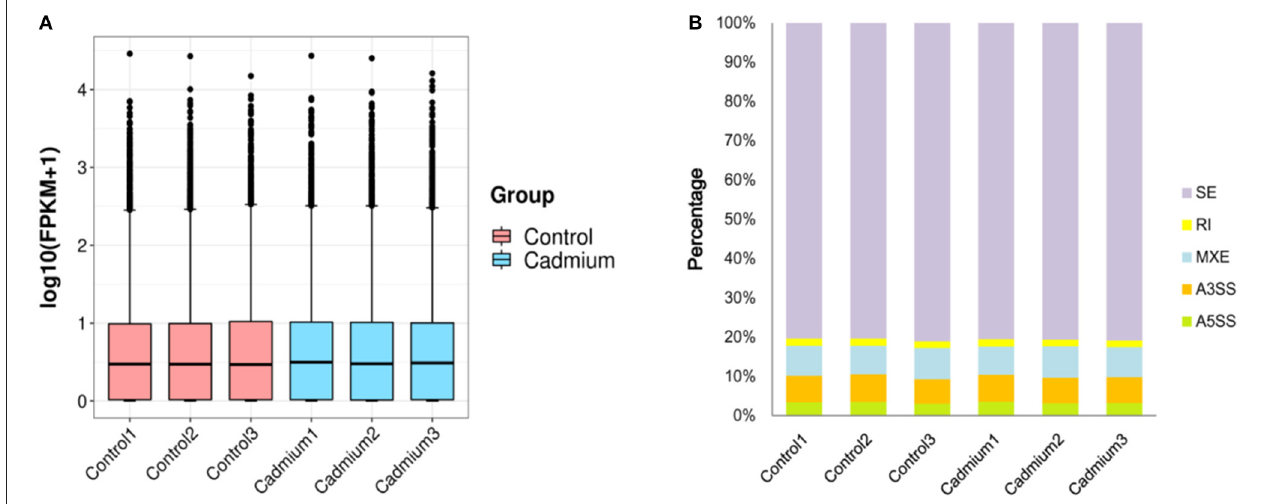
FIGURE 3 | Box plots and variable shear events. (A) Box plots of the gene expression levels: the X -axis is the sample name, the Y -axis is log10 (FPKM + 1), and each region of the box plot corresponds to five statistics (upper limit, upper quartile, median, lower quartile, and lower limit, respectively, from top to bottom, where upper and lower limits are not considered outliers). (B) Variable Shear Events: alternative 5’ splicing site (A5SS), alternative 3’ splicing site (A3SS), mutually exclusive exons (MXE), retained intron (RI), skipped exon (SE).